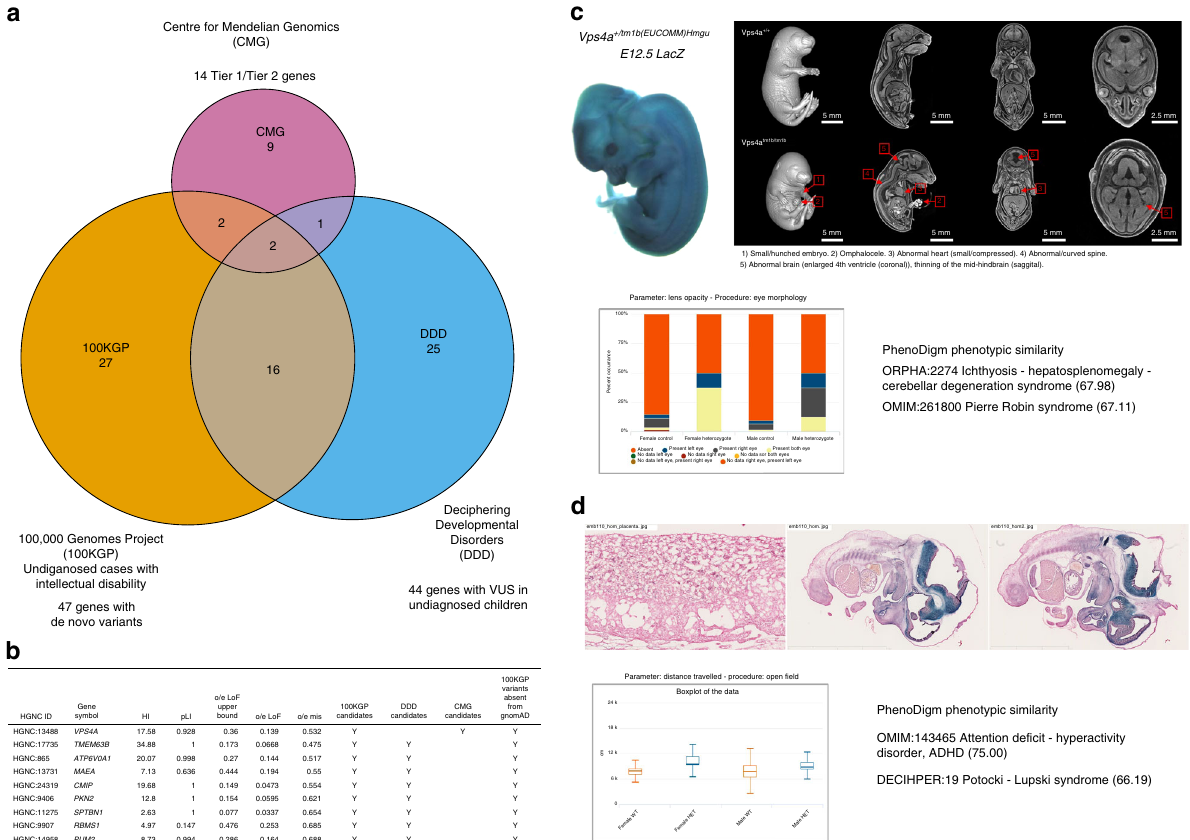
Fig. 4 Developmental disorders gene candidate prioritisation. a Venn diagram showing the overlap between DL prioritised genes with evidence from 3 large-scale sequencing programmes. Overlap between the set of 163 developmental genes highly intolerant to LoF variation (pLI > 0.90 or o/e LoF upper bound < 0.35 or HI < 10) and not yet associated with disease and the set of candidate genes from three large rare disease sequencing consortia: 100KGP, CMG, and DDD. b Set of nine candidate genes. The selected genes met the following criteria: (1) evidence from both the 100KGP (with detailed clinical phenotypes and variants) and either DDD (variants and high-level phenotypes available) or CMG (gene and high-level phenotypes available), (2) the associated variants were not present in gnomAD, and (3) intolerance to missense variation; these genes were further prioritised based on the number of unrelated probands and the phenotypic similarity between them and the existence of a mouse knockout line with embryo and adult phenotypes that mimic the clinical phenotypes. c Mouse evidence for VPS4A . IMPC embryonic phenotyping of homozygous mutants at E18.5 showed abnormal/curved spine and abnormal brain among other relevant phenotypes. The phenotypic abnormalities observed in heterozygous knockout mice include lens opacity. Heterozygous mouse phenotypic similarity to known disorders as computed by the PhenoDigm algorithm. d Mouse evidence for TMEM63B . IMPC homozygous mouse embryo lacZ imaging at E14.5 supporting neuronal expression during development. Heterozygous IMPC knockout mice associated phenotypes included abnormal behaviour evaluated through different parameters. The heterozygous mice showed a high phenotypic similarity with several developmental disorder phenotypes. VUS variant of unknown signi